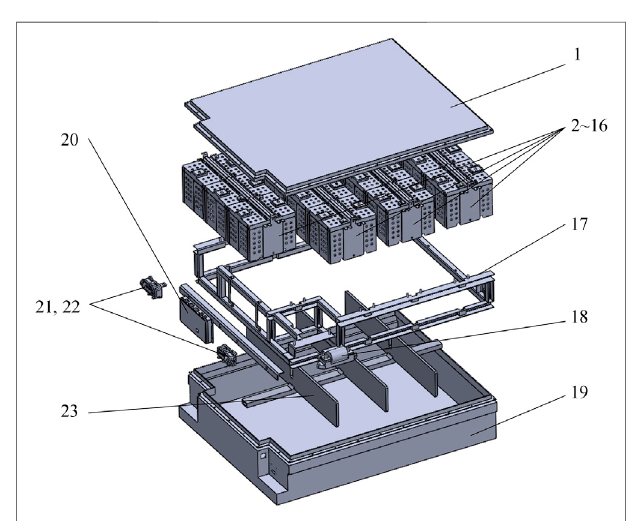
FIGURE 7 | Exploded view of a EVB.